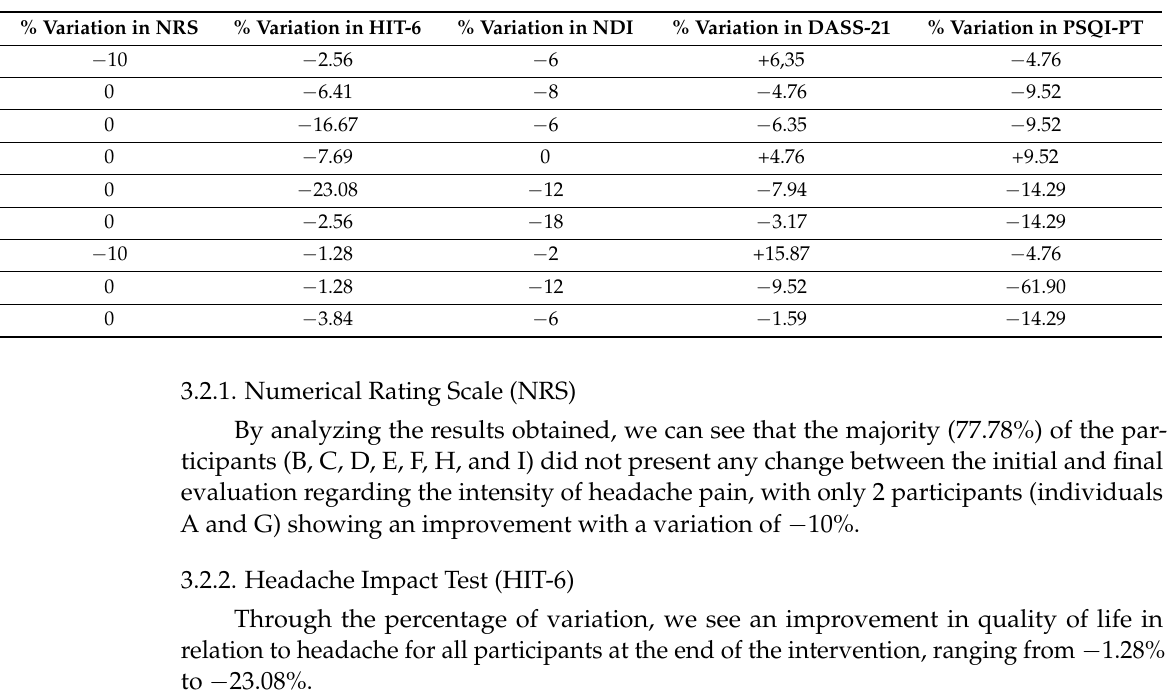
Table 3. Percentages of variation for the different